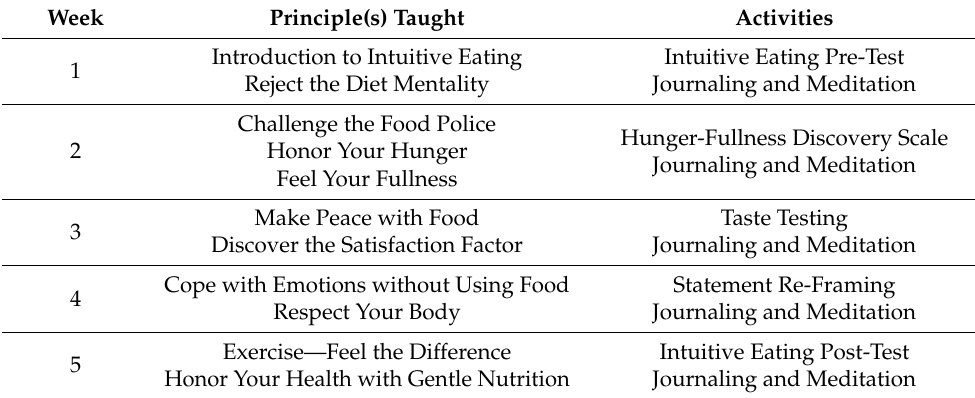
Table 1. Weekly breakdown of intuitive eating intervention content including intuitive eating principles taught and session